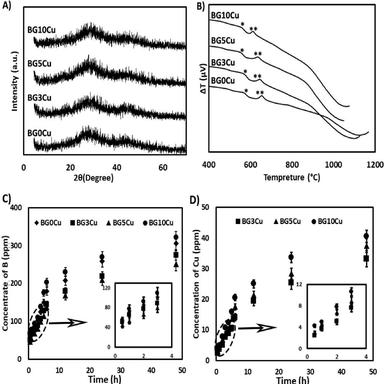
(A) An X-ray diffractionspectrum of the modified bioactive glasses (BGs) indicating glassy structures; (B) DTA curves of the modified BGs fabricated by using a meltequench technique ( represents Tg and represents Tc). (C, D) The cumulative amount of B and Cu ions released during immersion from the modified BGs into phosphate-buffered saline for each of the recorded times.